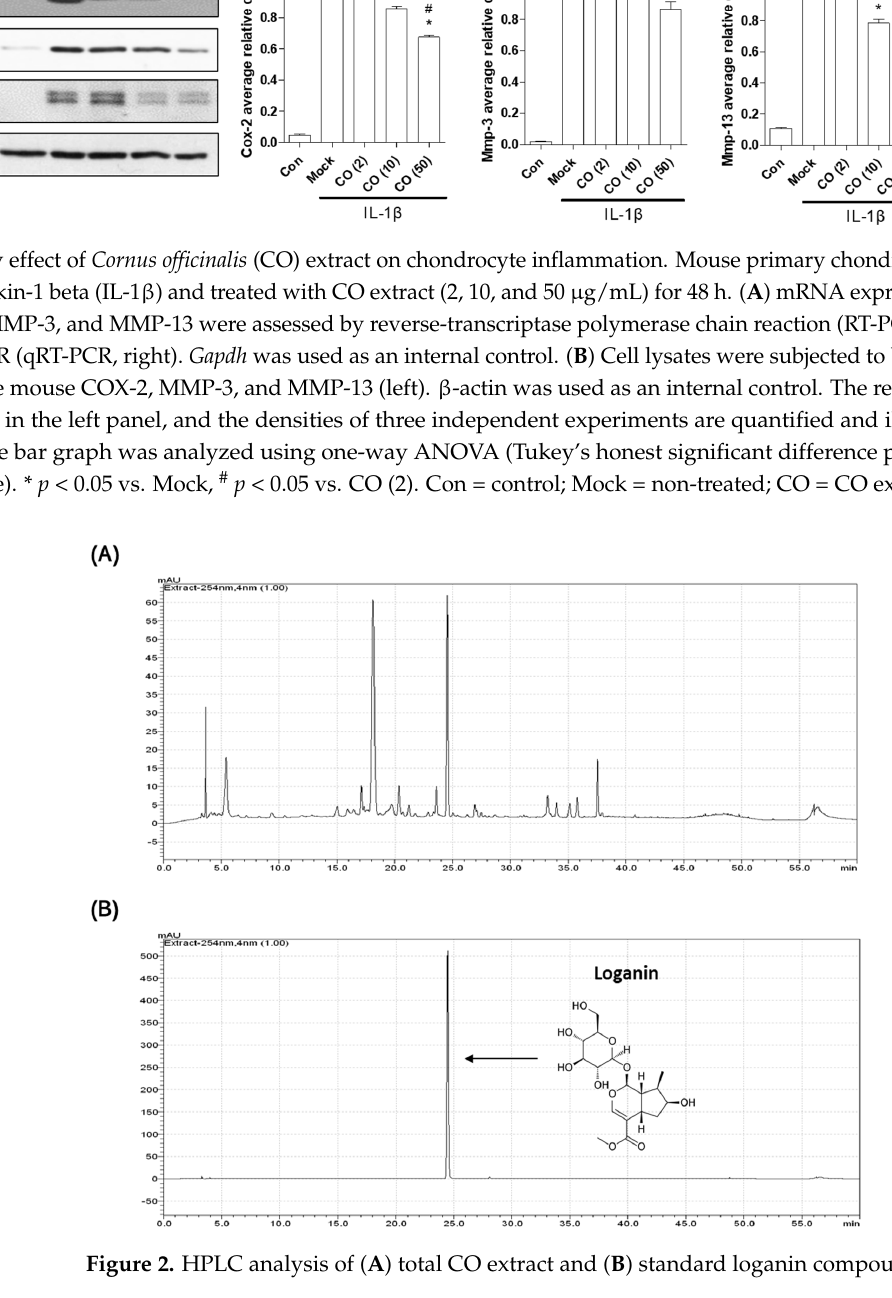
Figure 3. Loganin inhibits IL-1 β -induced inflammation in mouse primary chondrocytes. Mouse primary chondrocytes were incubated with IL-1 β (1 ng/mL) and loganin (2, 10, and 50 μ M) for 48 h. ( A ) mRNA expression levels of mouse COX-2, MMP-3, and MMP-13 were assessed by RT-PCR (left) and qRT-PCR (right). Gapdh was used as an internal control. ( B ) Cell lysates were subjected to Western blot analysis to evaluate mouse COX-2, MMP-3, MMP-13, and NF- κ B (left). β -actin was used as an internal control. The representative image is presented in the left panel, and the densities of three independent experiments are quantified and illustrated in the right panel. The bar graph was analyzed using one-way ANOVA (Tukey’s honest significant difference post-hoc test, analysis of variance). * p < 0.05 vs. Mock, # p < 0.05 vs. LO (2). Con = control; Mock = non-treated; LO = loganin.